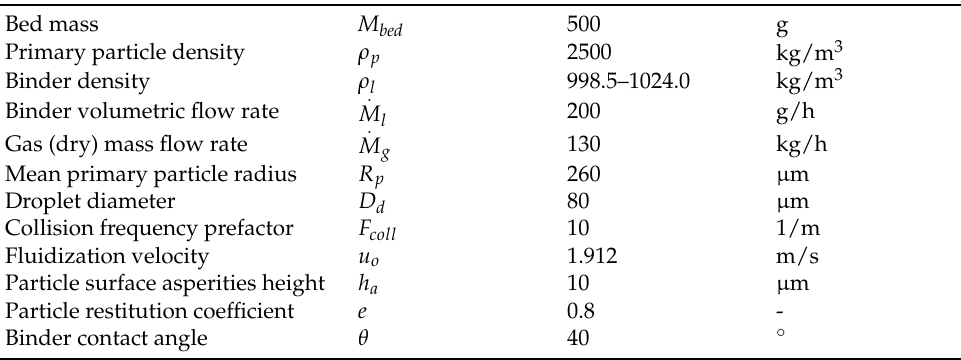
Table 2. Simulation and experimental parameters.